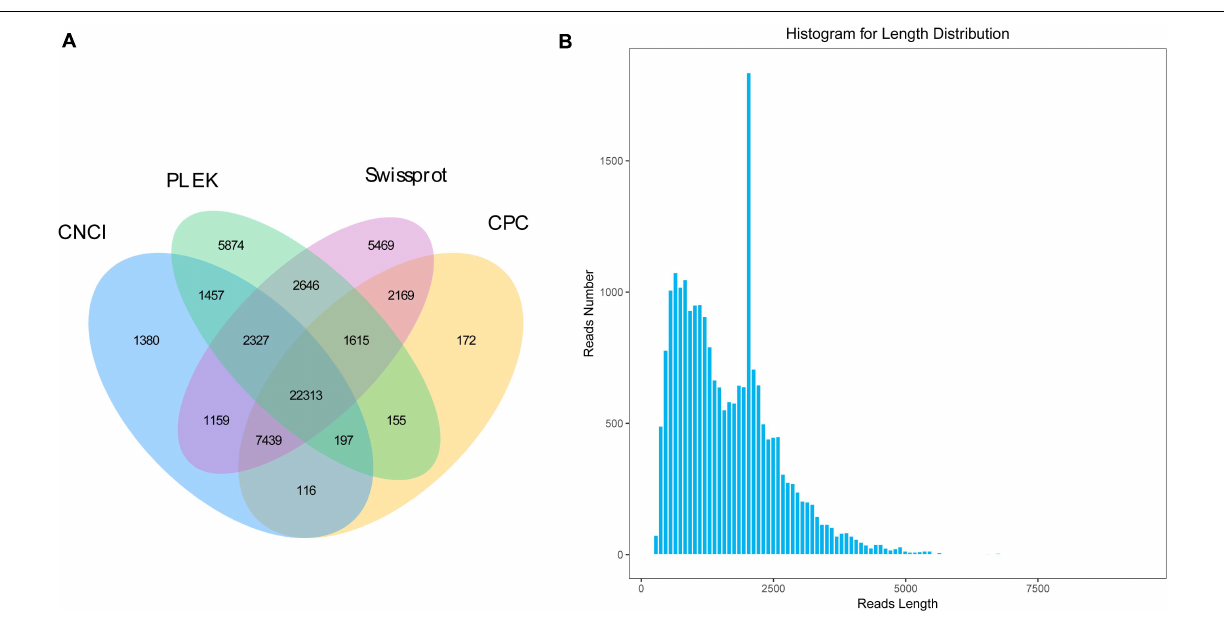
different stages of development in mud crab ( Figure 6 ).